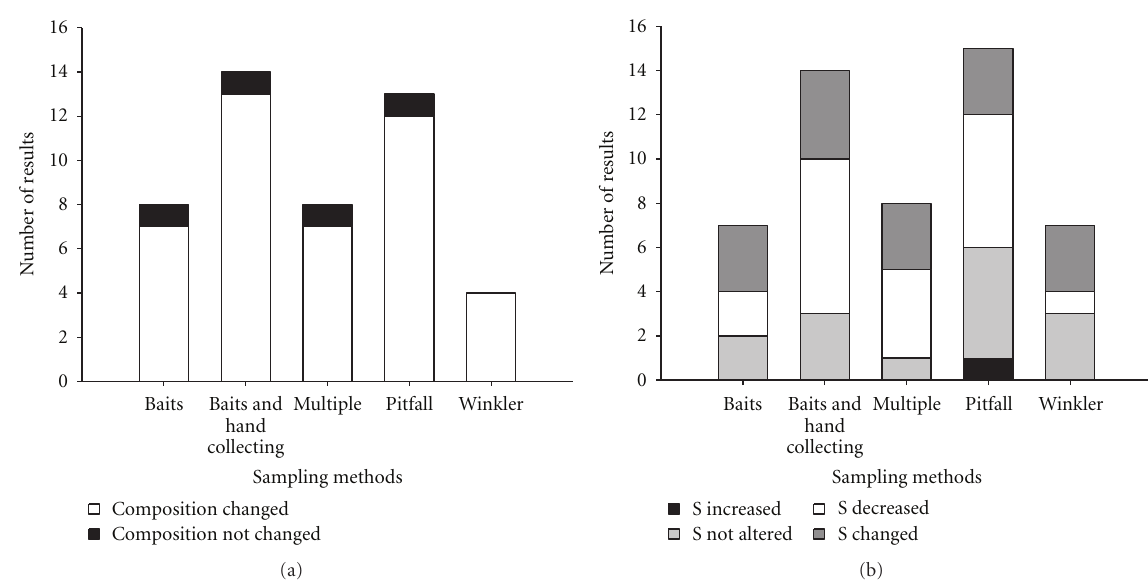
Figure 2: Papers that analyzed (a) ant species composition and/or (b) ant species richness/diversity with and without statistical tests and their responses to habitat disturbance through the use of di ff erent ant sampling methodologies. Composition changed—species composition altered by disturbance. Composition not changed—species composition not altered by disturbance. S increased—species richness or diversity increased with disturbance. S not altered—species richness or diversity not a ff ected by disturbance. S decreased—species richness or diversity decreased with disturbance. S changed—species richness or diversity changed with disturbance when there is any clear trend in the response of ants to disturbance.